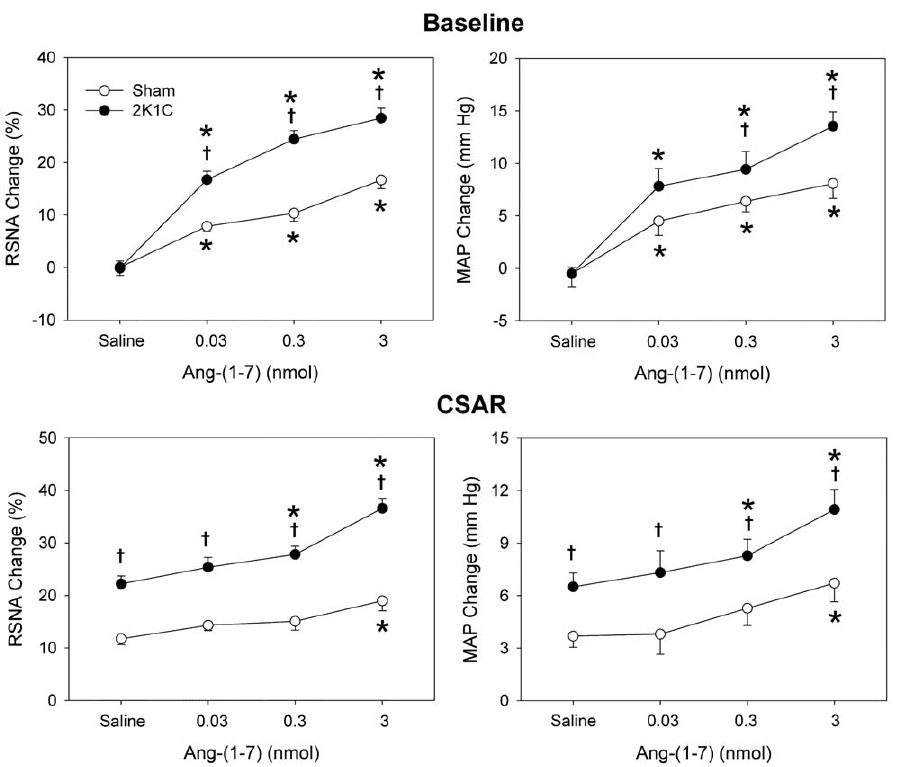
Figure 1. Effects of PVN microinjection of saline and three doses of Ang-(1–7) (0.03, 0.3 and 3 nmol) on the baseline RSNA and MAP and CSAR. The CSAR was evaluated by the RSNA and MAP responses to epicardial application of capsaicin (1 nmol). Values are mean 6 SE. * P , 0.05 compared with saline. { P , 0.05 compared with Sham. n=6 for each group.